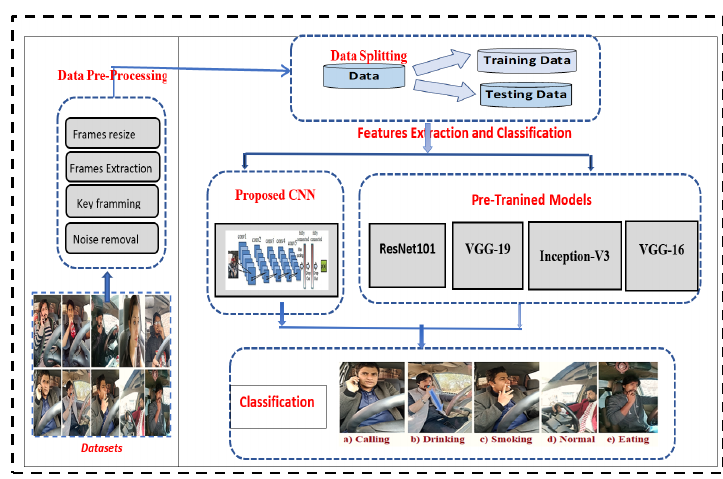
Figure 1. Proposed Framework for Driver Unusual behavior Detection.